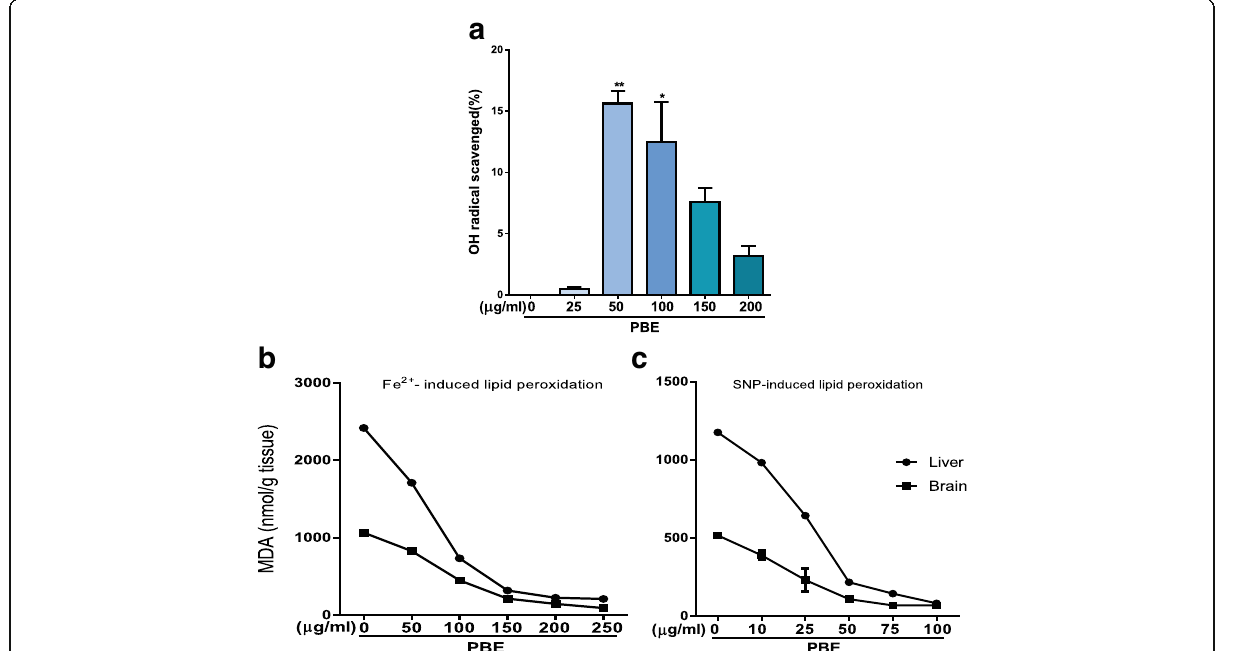
Fig. 2 Hydroxyl radical scavenging activity ( a ) and inhibition of Fe 2+ - ( b ) and SNP-induced ( c ) lipid peroxidation in rat tissues by P. biglobosa leaf extract. Results are mean ± SEM of three parallel